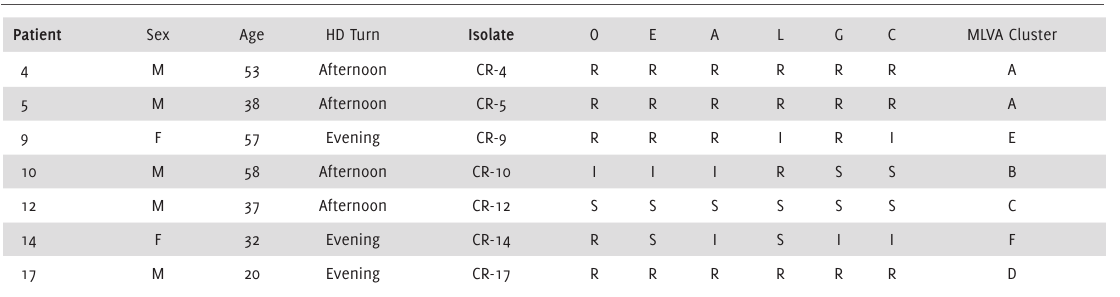
Table 4. Phenotypical and Genotypical Characteristics of Isolates Typed by MLVA.